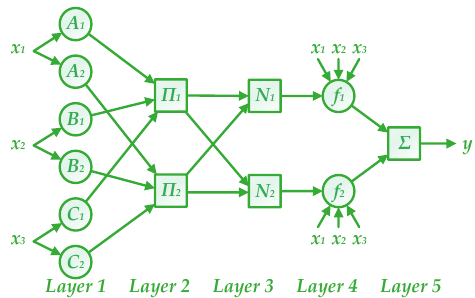
Figure 8. An example model of adaptive neural fuzzy inference system-fuzzy c-means (ANFIS-FCM) with 3 inputs and 2 clusters.